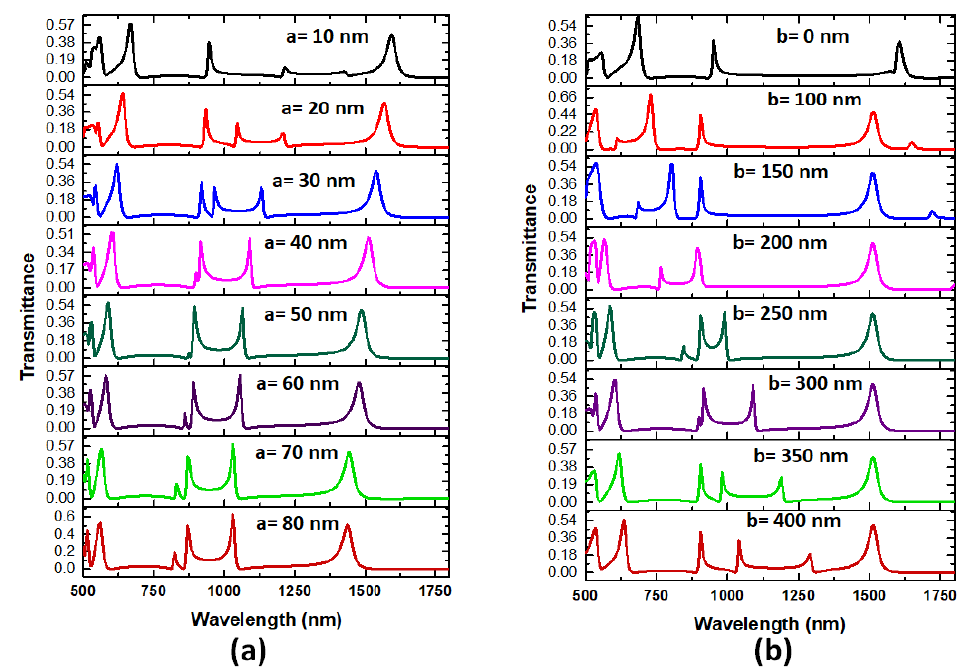
Figure 4. Transmittance spectrum of case 4 by varying ( a ) a = (10, 20, 30, 40, 50, 60, 70, 80) nm, and ( b ) d = (0, 100, 150, 200, 250, 300, 350, 400) nm, ( b ) d = (0, 100, 150, 200, 250, 300, 350, 400) nm, respectively.